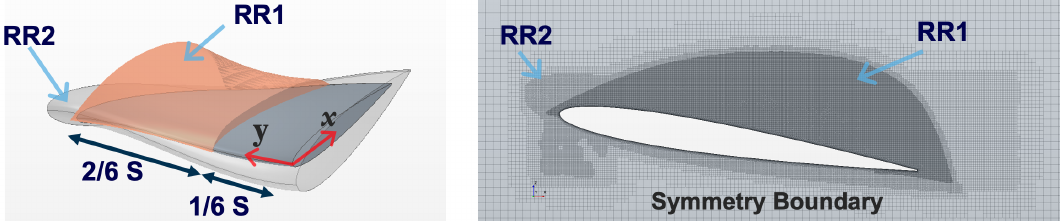
Figure 3. Refinement regions (RR) applied to generate computational mesh; S : the foil span